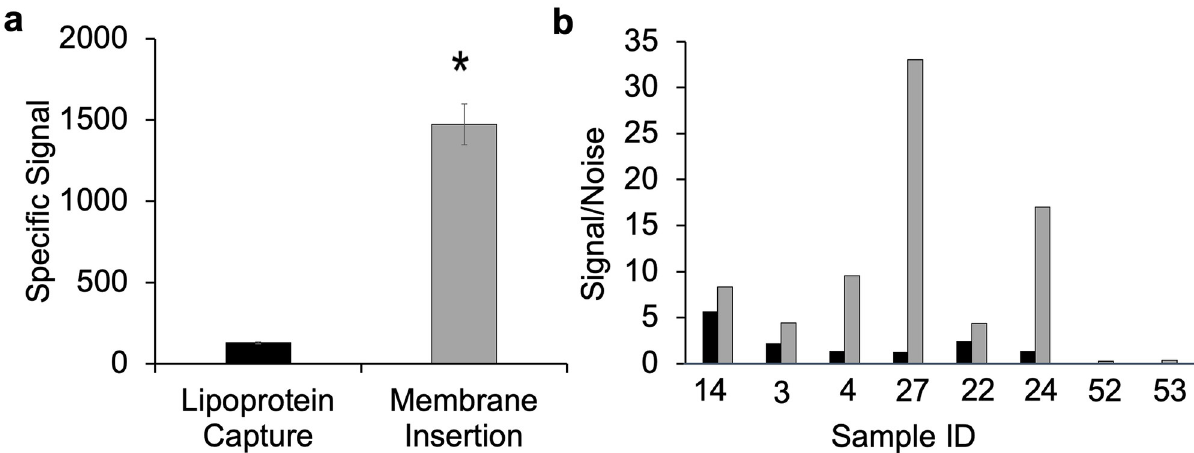
Fig 5. Comparison of lipoprotein capture and membrane insertion. (a) Representative measurement of LAM (0.5 μ M), by lipoprotein capture (black bars) and membrane insertion assay (grey bars), incubated overnight at 4 ˚C in control human serum, with the specific signal (RFU) from the detection of α -LAM antibody (15 nM). Values are the mean ± standard deviation derived from at least two independent determinations (n = 2). Statistical significance was determined by Welch’s t-test ( � P < 0.05). (b) Comparison of LAM detection signal by lipoprotein capture (black bars) and membrane insertion assay (grey bars) in patient serum samples. Data are presented as the S/N ratio with a value over 1 indicating a positive result. Samples 14, 3, 4, 27, 22 and 24 are positive for LAM by either blood or sputum culture methods, whereas samples 52, 53 are healthy controls.